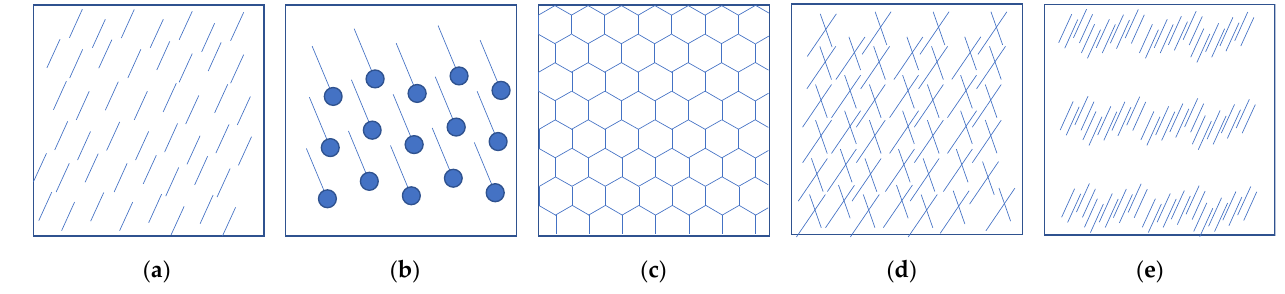
Figure 3. Texture directionality instances with different periodicity. ( a ) Simple line, periodicity 180 ◦ ; ( b ) oriented line, periodicity 360 ◦ ; ( c ) honeycomb, periodicity 120 ◦ ; ( d ) multiple directionalities coexisting at the same scale; ( e ) multiple directionalities coexisting at different